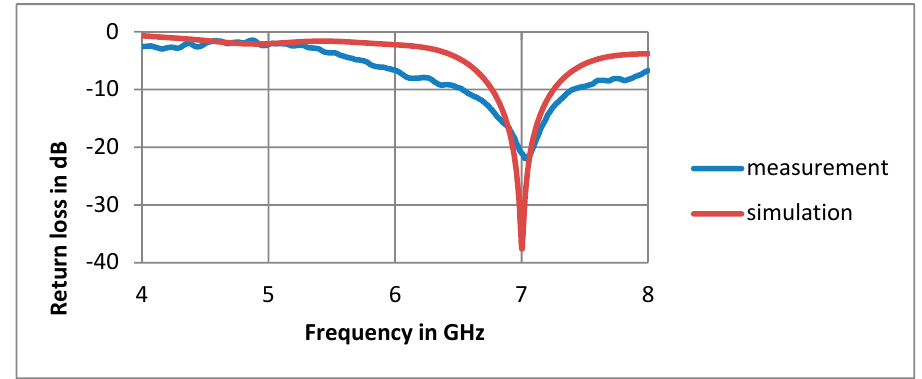
Figure 10. The simulated and measured return loss of antenna B with thickness of 1.27 mm.